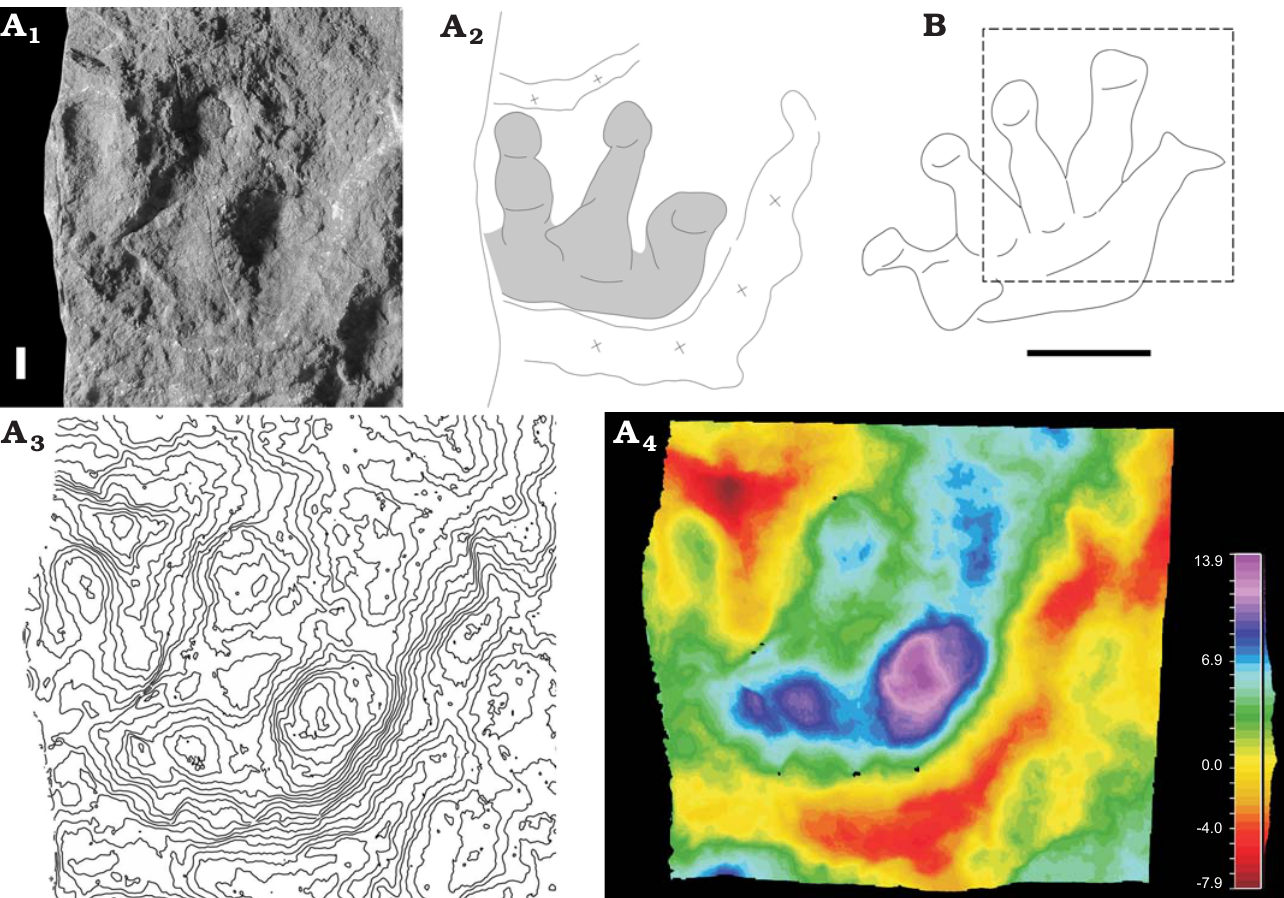
Fig. 8. A . Undetermined track (MCV 14/30) of therapsid synapsid from Cortiana (Italy), Lopingian. Incomplete right manual impression showing digits III–V and deep expulsion rims. Concave epirelief, spacing 1 mm. Photo (A 1 ), interpretive drawing (A 2 ), contour lines (A 3 ), false-color depth map (A 4 ). B . MGP 9/22, interpretive drawing of a complete left manual impression from the Bletterbach Gorge, Dolomites (Italy), Lopingian, after Conti et al. (1977). Scale bar 10